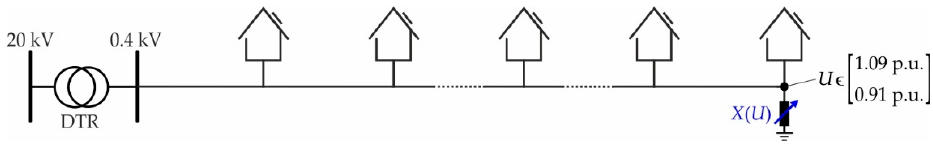
Figure 8. X ( U ) local control strategy.